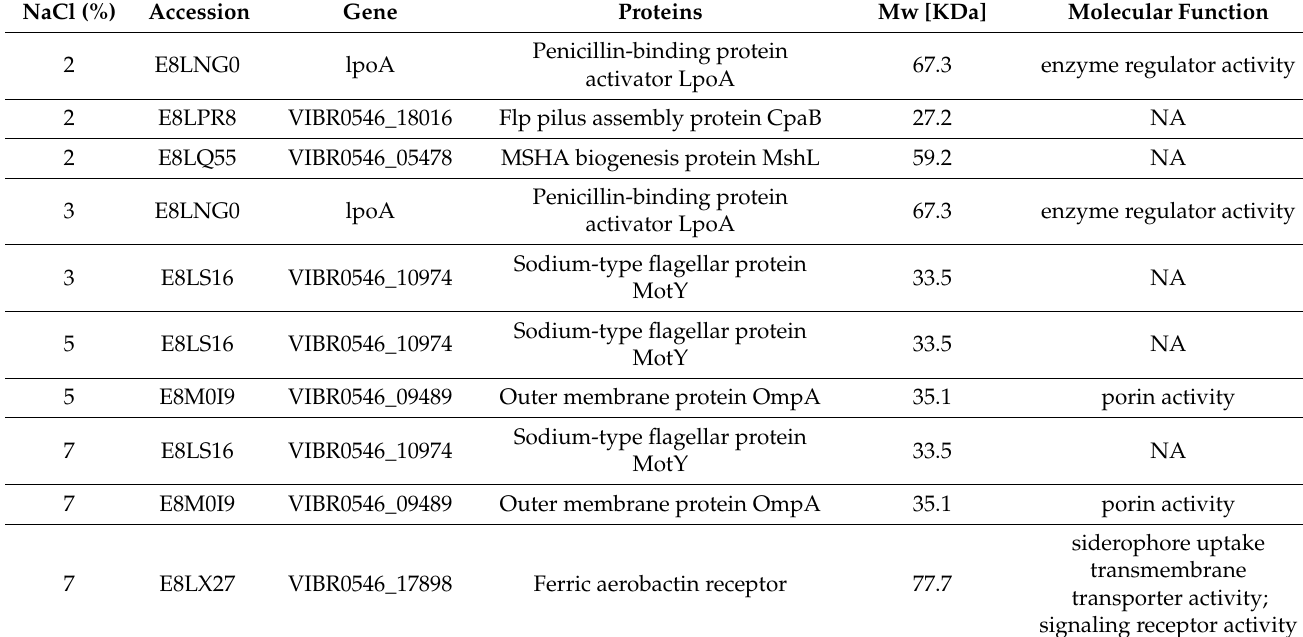
Table 1. The special expression outer membrane proteins of V. brasiliensis in different NaCl concentra- tions